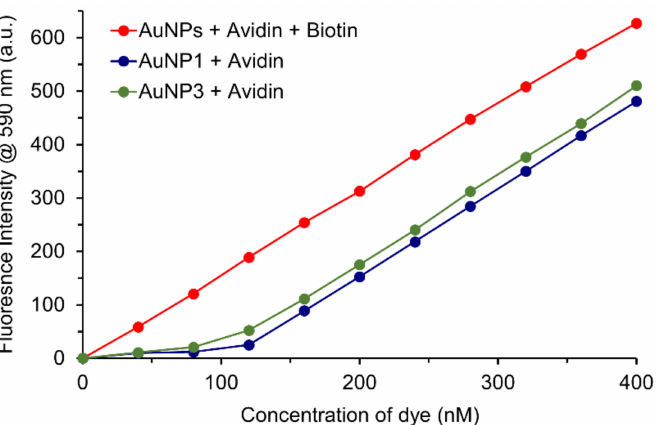
Figure 3. Results of the fluoresce titration experiments for AuNP1 and AuNP3. Control experiments in the present of biotin yielded identical data, only one set is shown for clarity. All AuNPs solutions set at 0.8 absorbance at 520 nm. Relevant results are also reported in Table